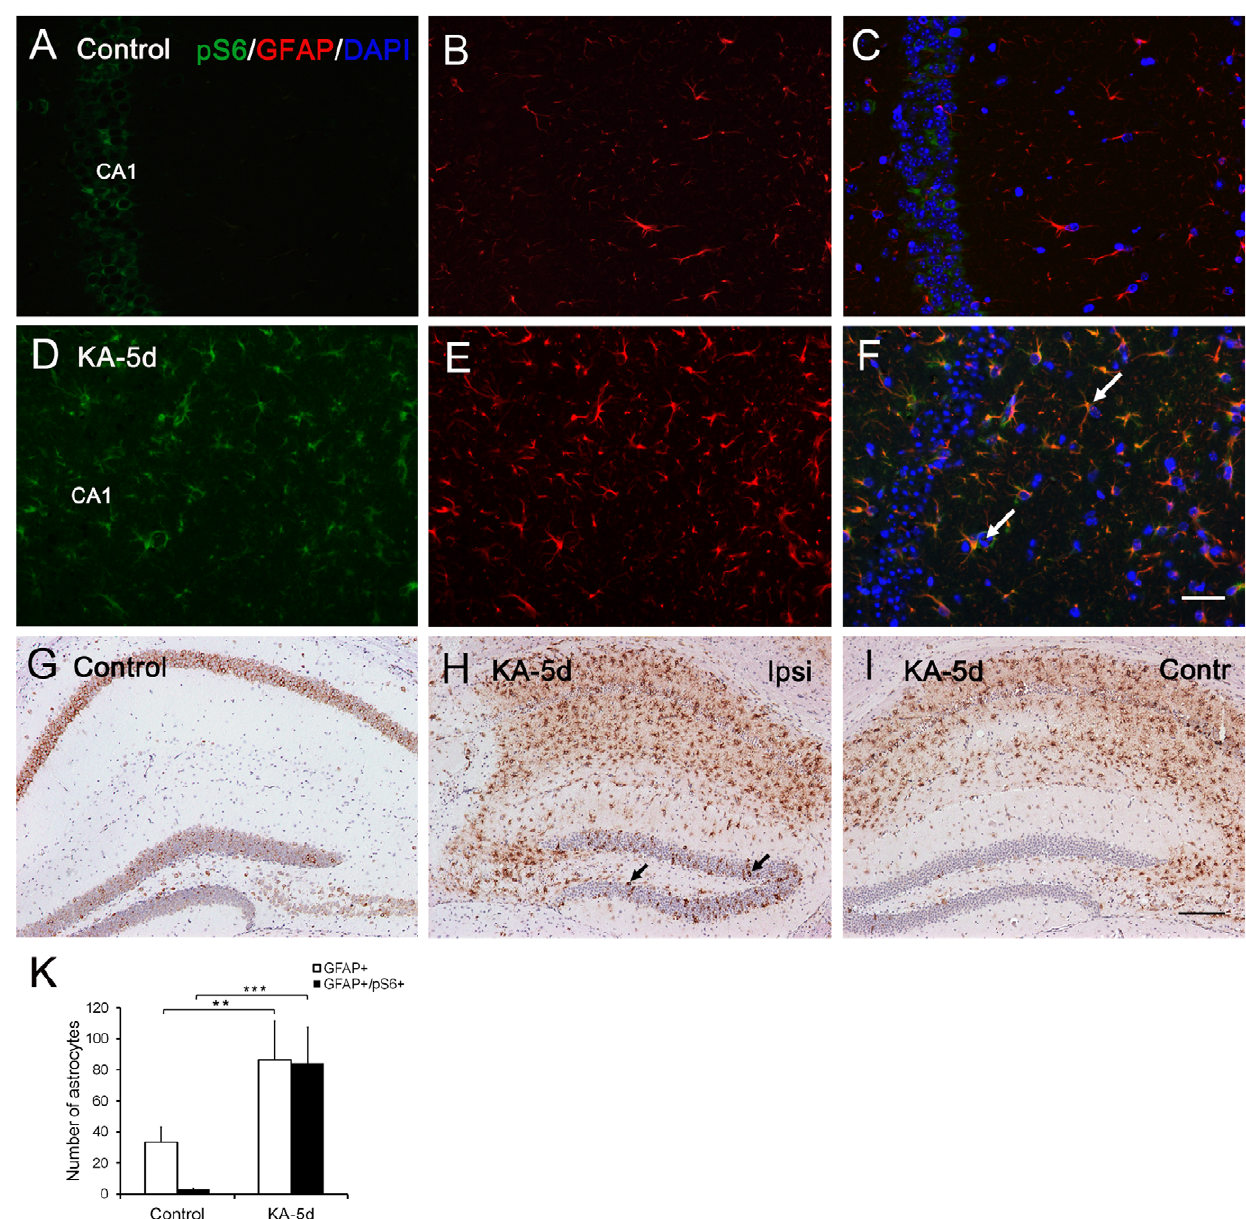
Figure 2. Distribution of pS6 in the hippocampus of control mice and 5 days after induction of seizures. In CA1 of saline-injected control mice (n=4), pS6 (green) is present in the cytoplasm of pyramidal neurons (A). Immunofluorescent staining of GFAP (red) shows distribution and morphology of astrocytes under normal physiological conditions (B). There is no colocalization of pS6 and GFAP (C). During the latent phase, increased pS6 expression is observed in the CA1 subfield of KA-injected hippocampus (n=4) (D), and colocalizes with GFAP, mostly in astrocyte-like cells (arrows in F). Reactive gliosis is indicated by dramatically elevated GFAP (E). pS6 positive glia are present in hippocampus both ipsilateral (ipsi, H) and contralateral (contr, I) to KA injection, although elevation of the former is more significant. Compared with saline-injected control hippocampus (G), dentate gyrus of hippocampus ipsilateral to KA injection (H) contains fewer granule cells with strong pS6 IR (arrow in H), while almost no pS6 positive granule cells are present in the contralateral, non-injected hippocampus (I). (K) Quantification of GFAP positive and pS6/GFAP double positive cells in CA1 subfield of KA-injected mice (n=4) versus control mice (n=4) at the second stage. Error bars are means 6 SD., **P , 0.01; ***P , 0.001 is based on Student’s t-test. Scale bar in A-F: 100 m m; in G-I: 200 m